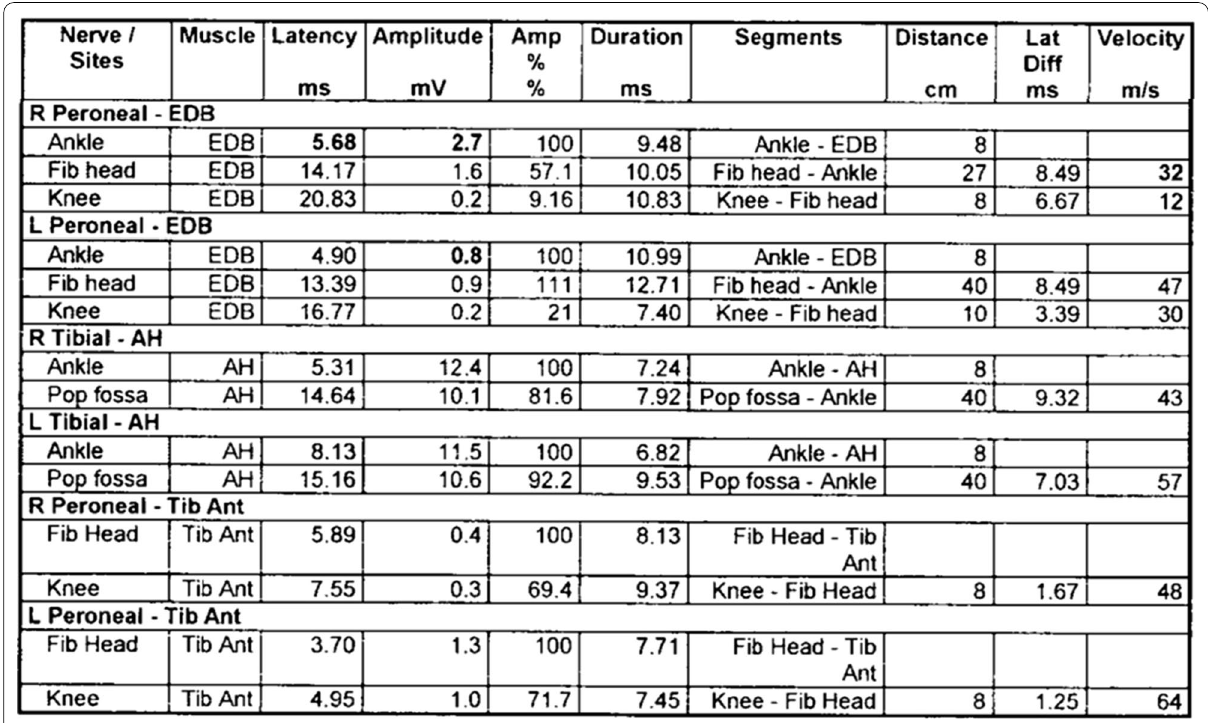
Fig. 2 Lower limb motor nerve conduction study results showing bilateral entrapment neuropathy at knee level characterised by severe reduction in CMAP amplitudes and reduced motor conduction velocities